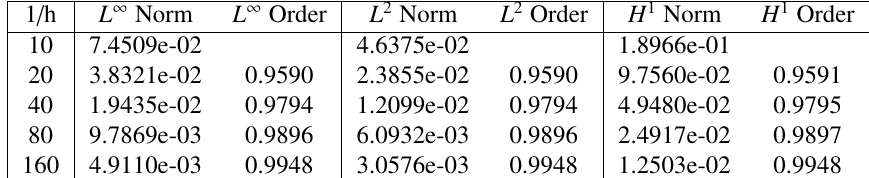
Table 3. Errors and Convergence Rate for Quadratic IFEM-BE Approximation for Example 1